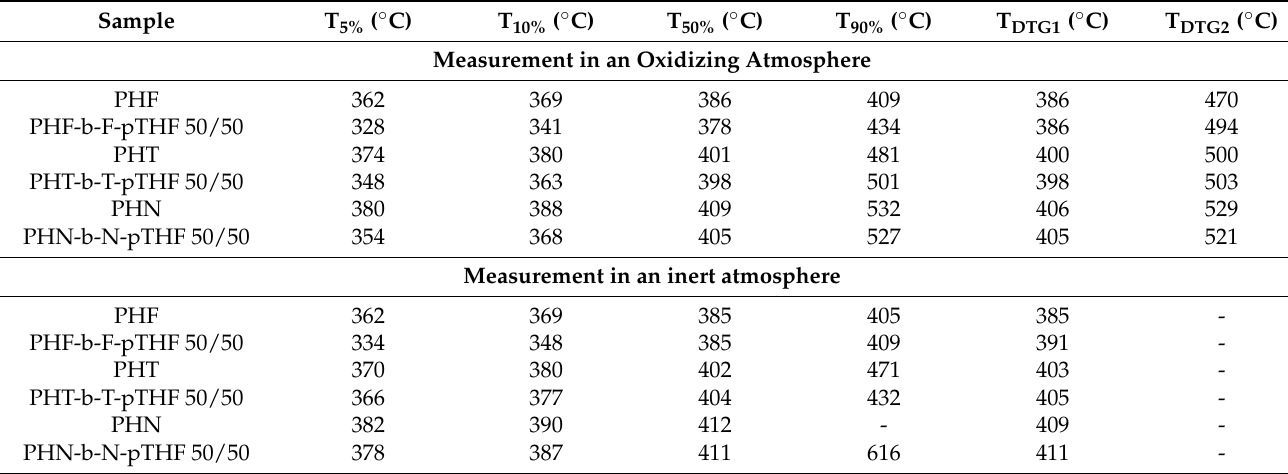
Table 6. TGA data: temperatures of 5%, 10%, 50%, 90% mass loss, the temperatures corresponding to Table 1 and T DTG2 ) in an oxidizing and inert